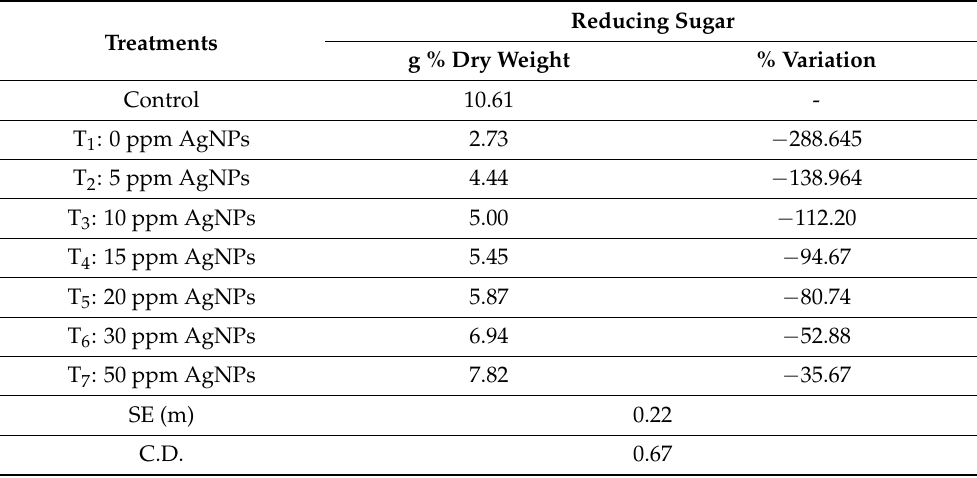
Table 2. Estimation of reducing sugar in spot blotch infected wheat plant leaves in response to nanoparticle treatment.